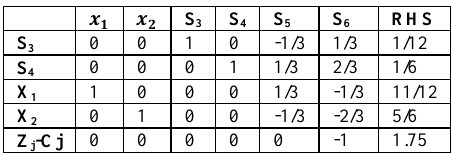
Table 1. Feasible solution of the LP model